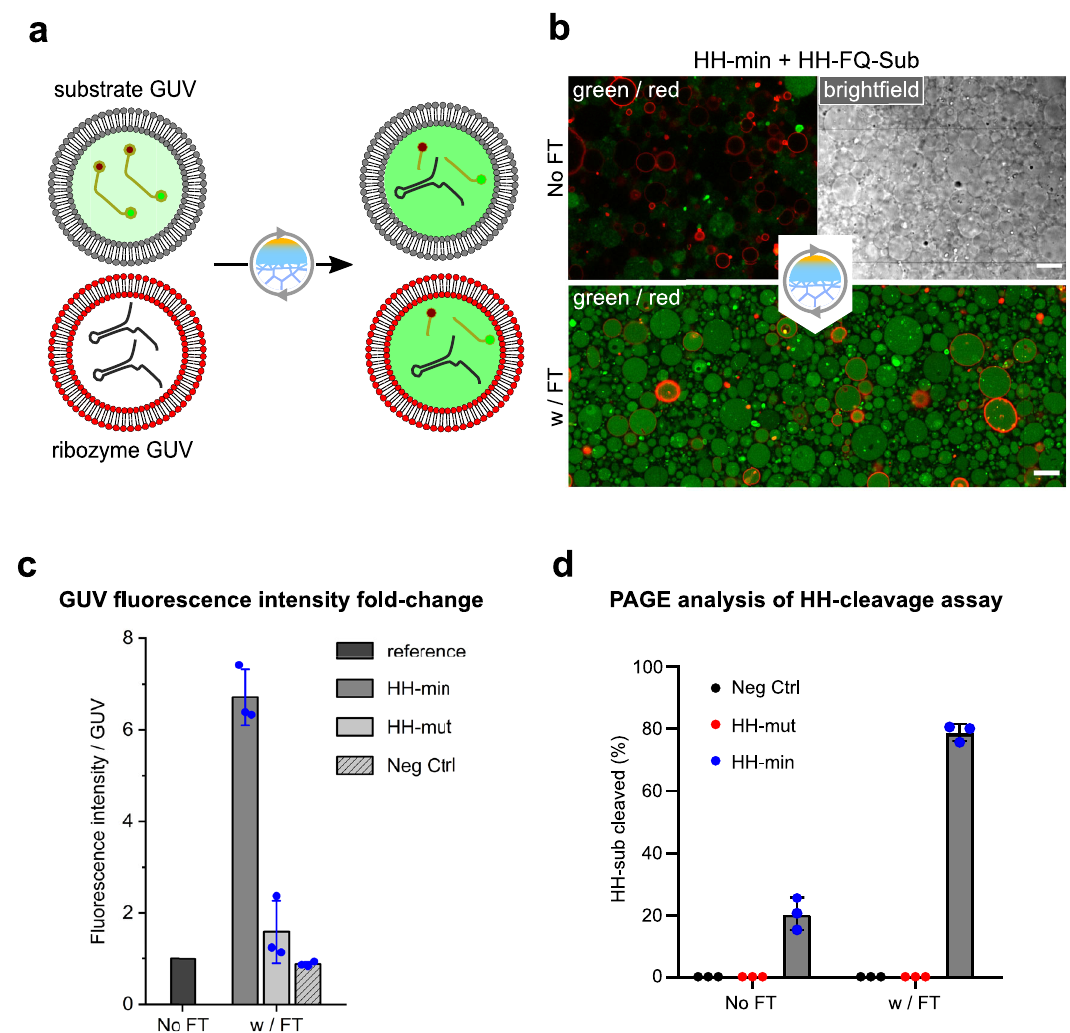
Fig. 1 | Freeze-thaw (FT) driven catalysis of a split hammerhead system encapsulated in vesicles. a Illustration showing reaction setup for the split ham- merhead system encapsulated in giant unilamellar vesicles (GUVs). HH-min con- taining GUVs (red membrane lipid) were combined with HH-FQ-Sub containing GUVs (grey)in1:1 ratio and subjected to asinglefreeze-thaw(FT)cycle. b Confocal microscopy of 2.5 µ M HH-FQ-Sub GUVs and 5 µ M HH-min GUVs before (top) and after (bottom) a FT-cycle in 20mM Tris-HCl pH 8.3, 4mM MgCl 2 , and 900mM sucrose/glucose. c Fold change of fl uorescence intensity per GUV after one FT- cycle, normalised to the average fl uorescence intensity of all GUVs in the sample before freezing. Negative Control (Neg Ctrl) had empty vesicles combined with